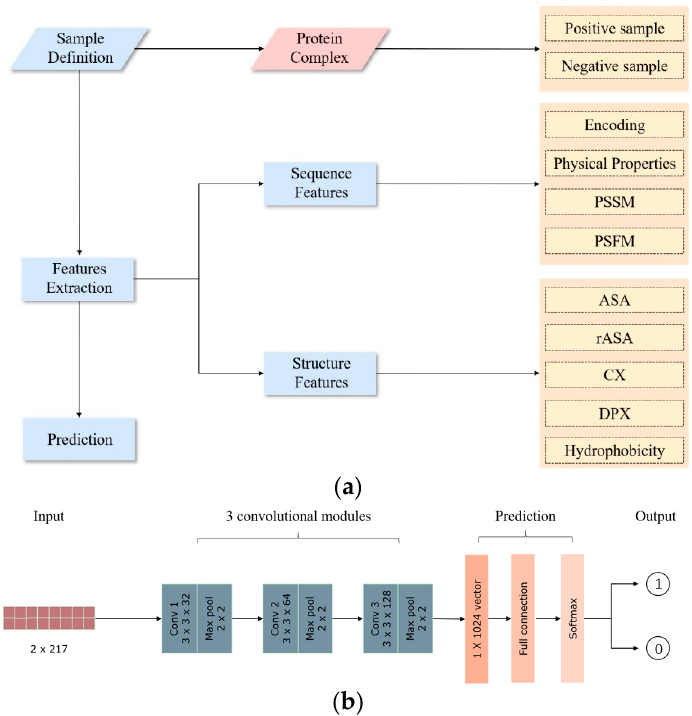
Figure 5. The process of prediction of PPI sites. ( a ) The overall flow chart for predicting pairs of interacting residues in this paper; ( b ) the structure of the convolutional neural network.